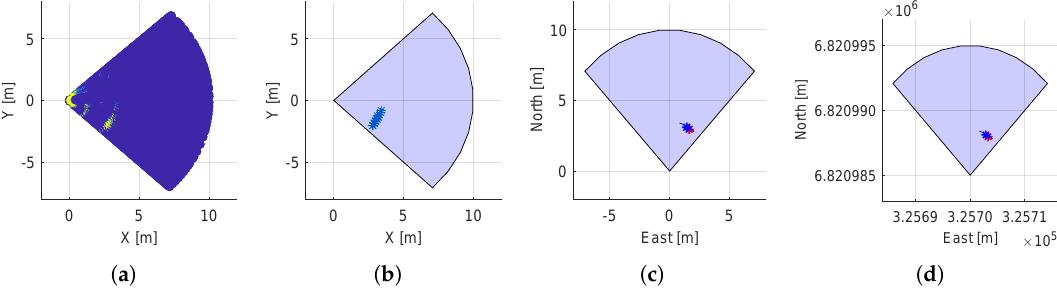
Figure 7. Post-processing of the mechanical imaging sonar data in the target detection algorithm: ( a ) Scan data acquired from sonar. ( b ) Post-processing based on Algorithm 1. ( c ) Relative position in NED with origin as [0,0] and calculation of target’s origin. ( d ) Absolute position in NED of the